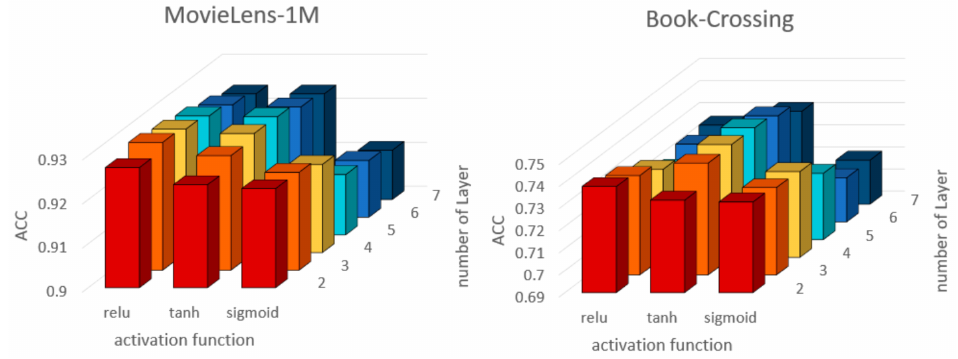
Figure 7. Model performance under different activation functions and different quantity